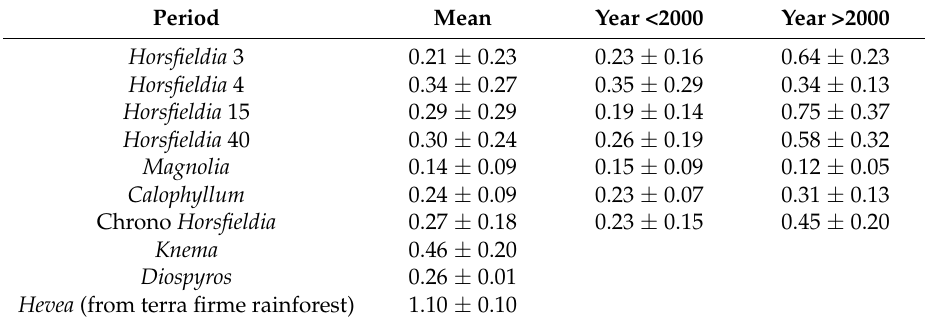
Table 4. Diameter increment (cm year − 1 ) together with the standard deviations of different species and different samples and the mean chronology from Horsfieldia. Displayed are the mean over the entire measuring period, the means from youth until the year 1999 and the means from the year 2000 until 2014. The samples from Knema and Hevea are too young for a comparison of the mentioned time